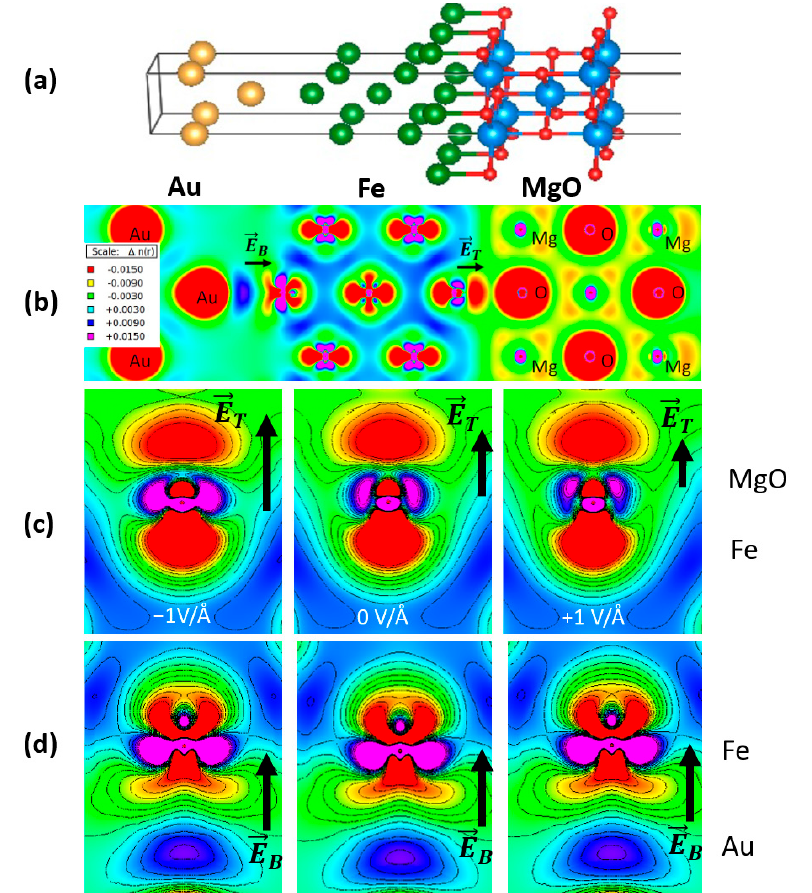
Figure 4. ( a ) Supercell model used in the ab-initio calculation for X /Fe(t Fe )/MgO stack. ( b ) Valence charge distribution calculated for Au/Fe(5ML)/MgO at zero electric field, corresponding to (110) section of the supercell-complete stack. ( c ) zoom at the top Fe/MgO and ( d ) bottom Au/MgO interfaces illustrating the effect of an external electric field on the top and bottom interface intrinsic fields E T and E B (adapted from [28]).